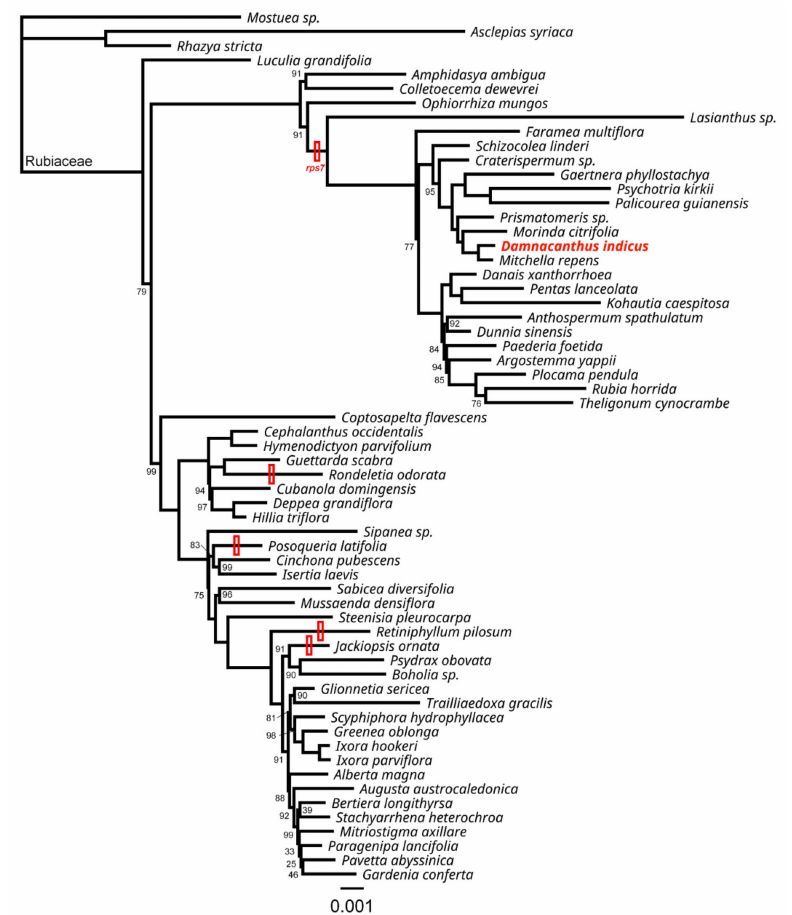
Figure 3. Maximum likelihood phylogeny of Rubiaceae based on concatenated mitochondrial genic regions (40,810 bp in the aligned length). Bootstrap values that are not 100 are shown at the nodes. The scale indicates the number of nucleotide substitutions per site. Branches leading to taxa or taxon with rps7 loss are marked with empty red bars. The newly sequenced mitogenome of Damnacanthus indicus is highlighted with red